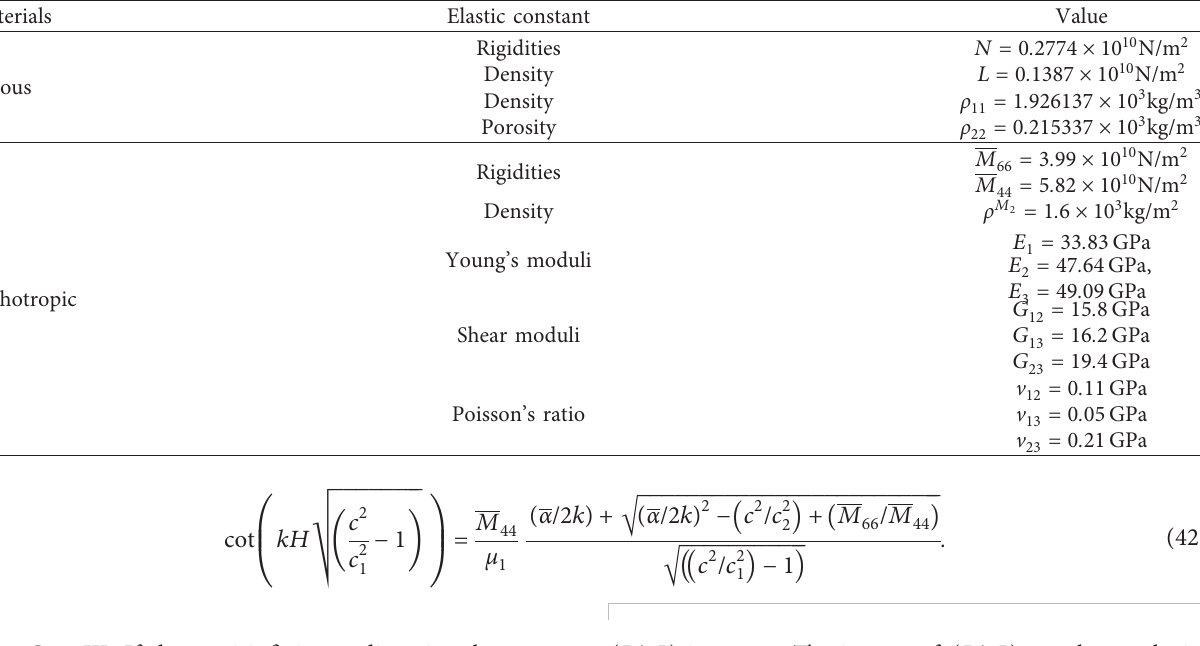
Table 2: General data for the proposed Earth